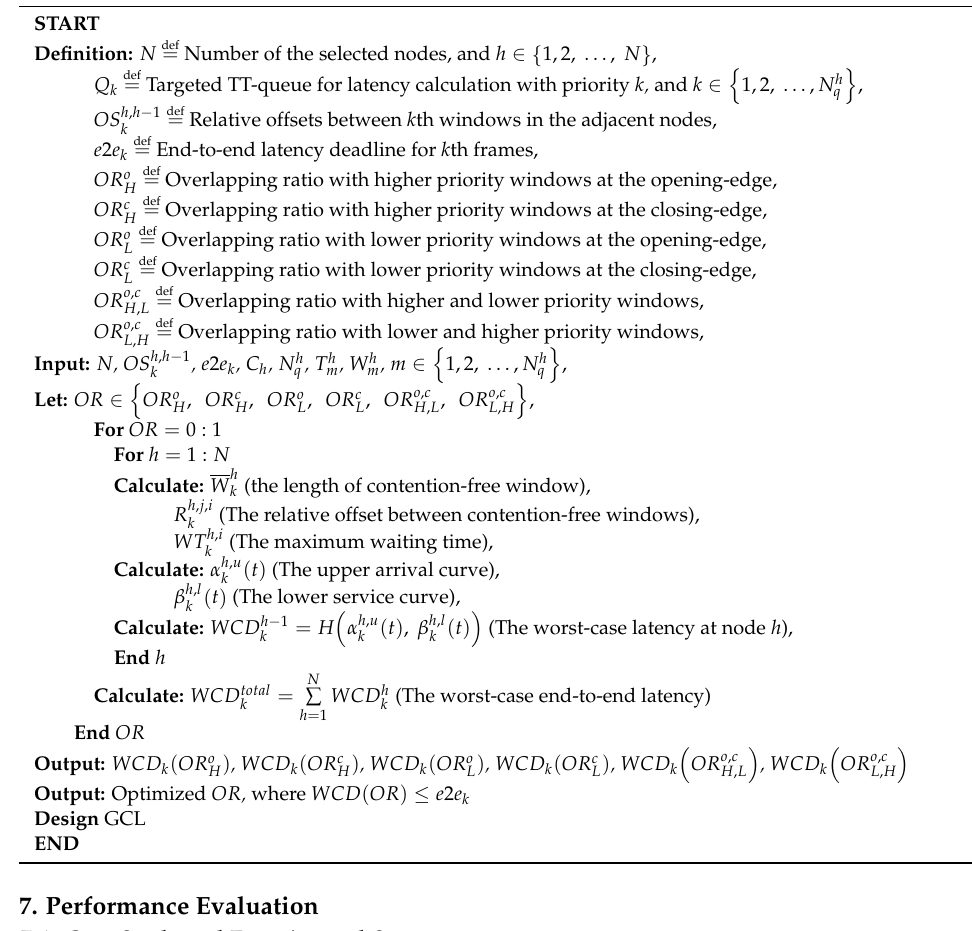
Algorithm 1. Flexible Window-Overlapping Scheduling (FWOS) Algorithm